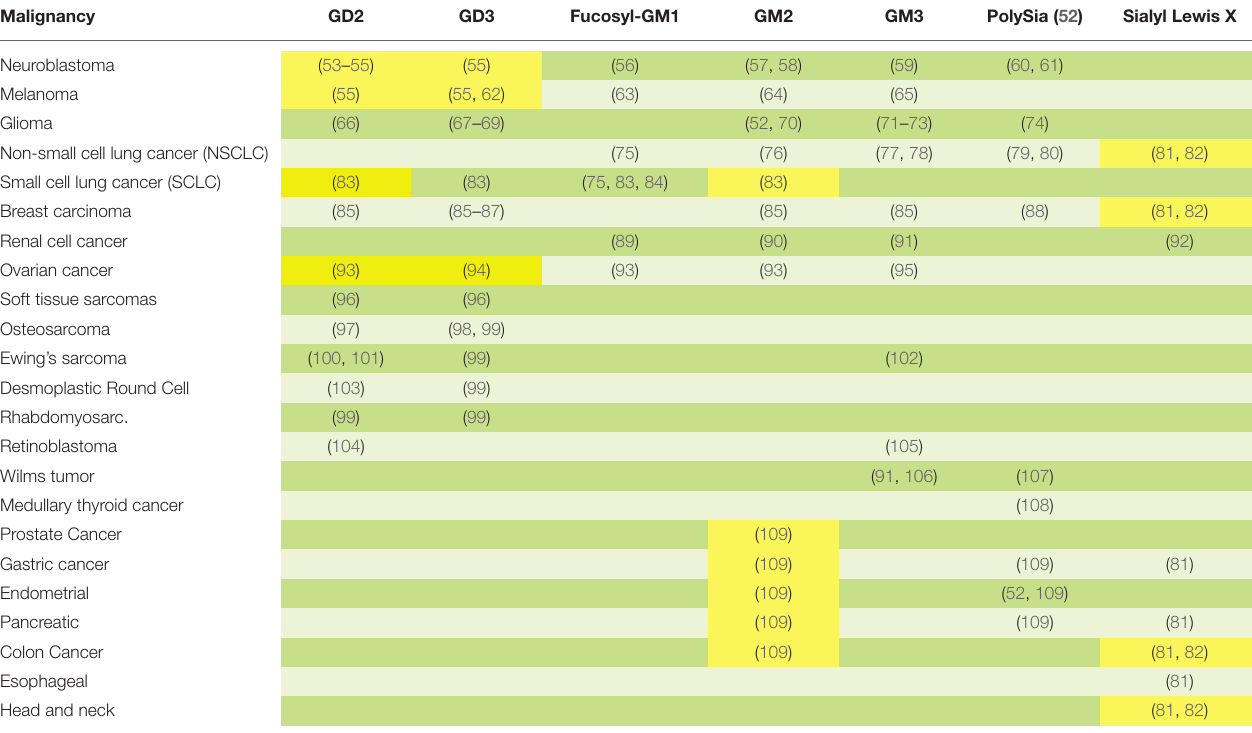
TABLE 1 | Tumor marker ganglioside